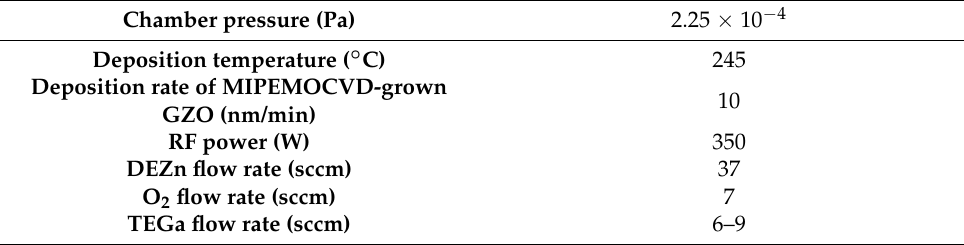
Figure 1. ( a ) Schematic MIPEMOCVD system and the modified intake system of organic precursors (right-hand), ( b ) Ga content and carrier concentration of PEMOCVD- and MIPEMOCVD-grown GZO thin films grown with varying TEGa flow rate, and ( c ) the average thickness of MIPEMOCVD- and PEMOCVD-grown GZO thin films at different position on glass substrate. Table 1. Deposition conditions of GZO thin films grown by using MIPEMOCVD system.